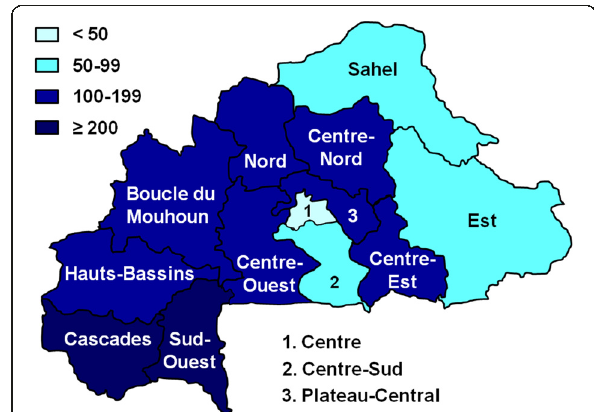
Fig. 2 Geographic distribution of snakebites in Burkina Faso (annual mean incidence per 100,000 population)